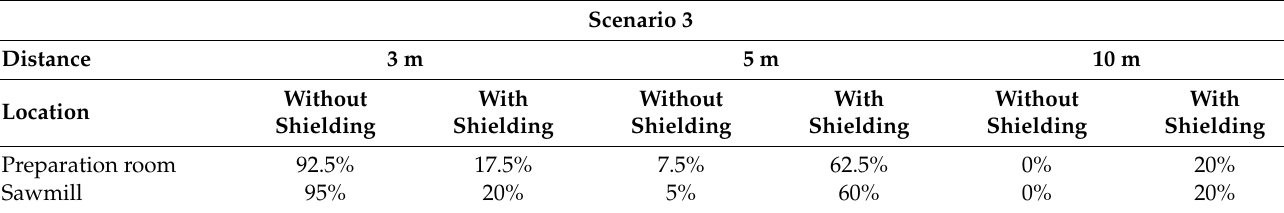
Table 4. Scenario 3: Success rate of determining distance from gateways.